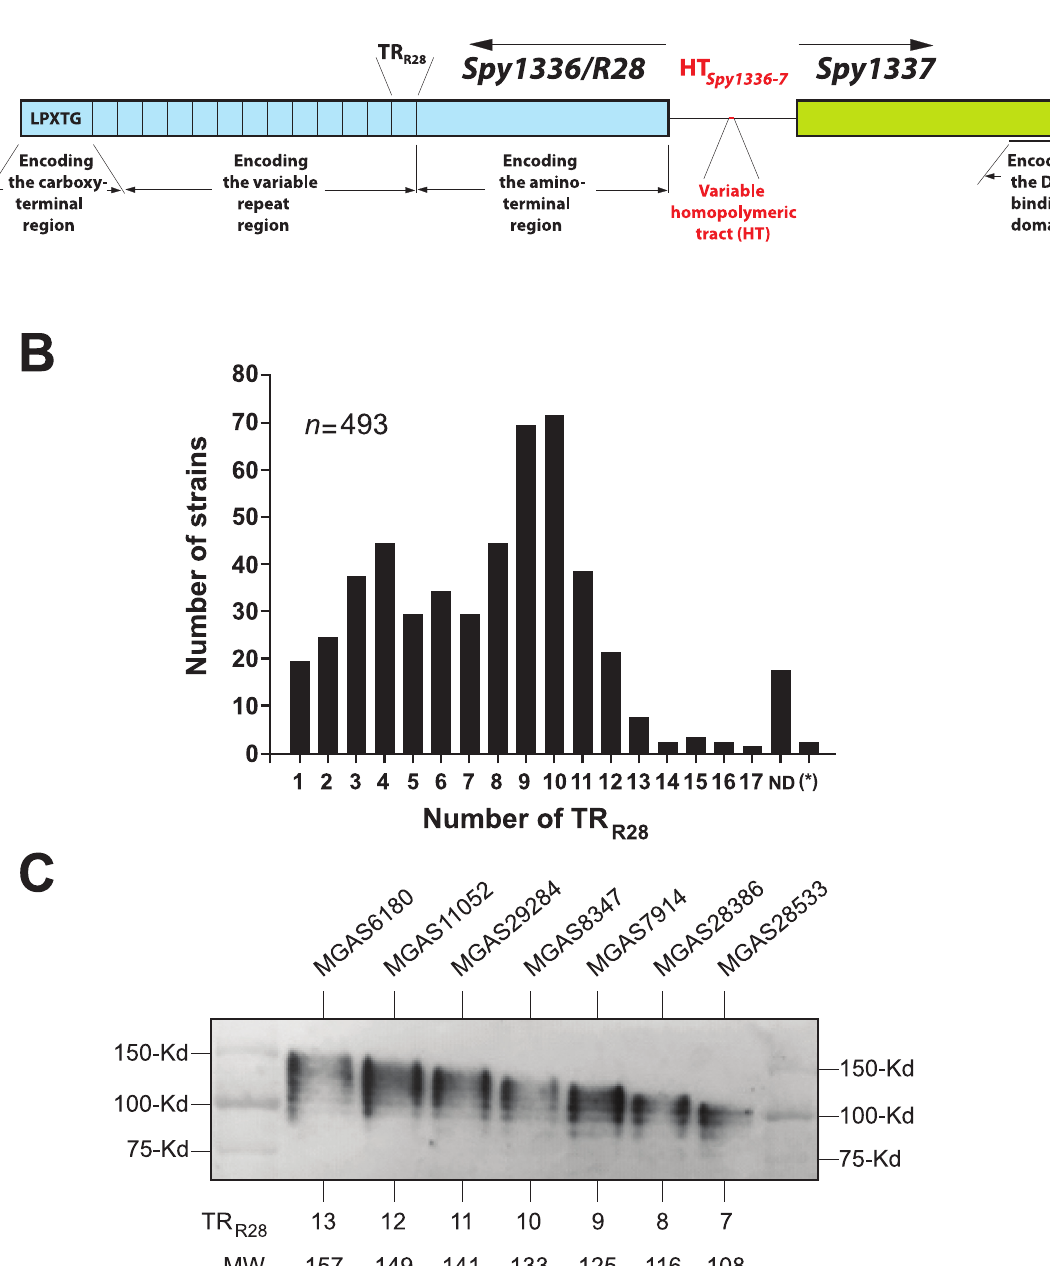
Fig 1. Analysis of the number of tandem repeats in the R28 protein. (A) Schematic of Spy1336/R28 , encoding R28, and Spy1337 . HT Spy1336-7 refers to the variable homopolymeric tract. TR R28 refers to one 79-amino acid tandem repeat. LPXTG is the consensus sequence for peptidoglycan attachment. Regions encoding the amino-terminal, carboxy-terminal, and variable repeat regions are indicated. DNA binding domain refers to two predicted helix- turn-helix DNA-binding motifs. Schematic is not drawn to scale. (B) Data shown correspond to 493 strains. ND, not determined. ( � ), two strains studied did not contain the RD2 mobile genetic element, as confirmed by inspection of bam files using TABLET [78]. (C) Western immunoblot of strains with R28 proteins containing different numbers of TR R28 , inferred based on gene sequence data. All strains analyzed had an HT 10Ts because 9T strains do not produce detectable R28 protein. TR R28 , number of tandem repeats per strain. MW, inferred molecular weight of the R28